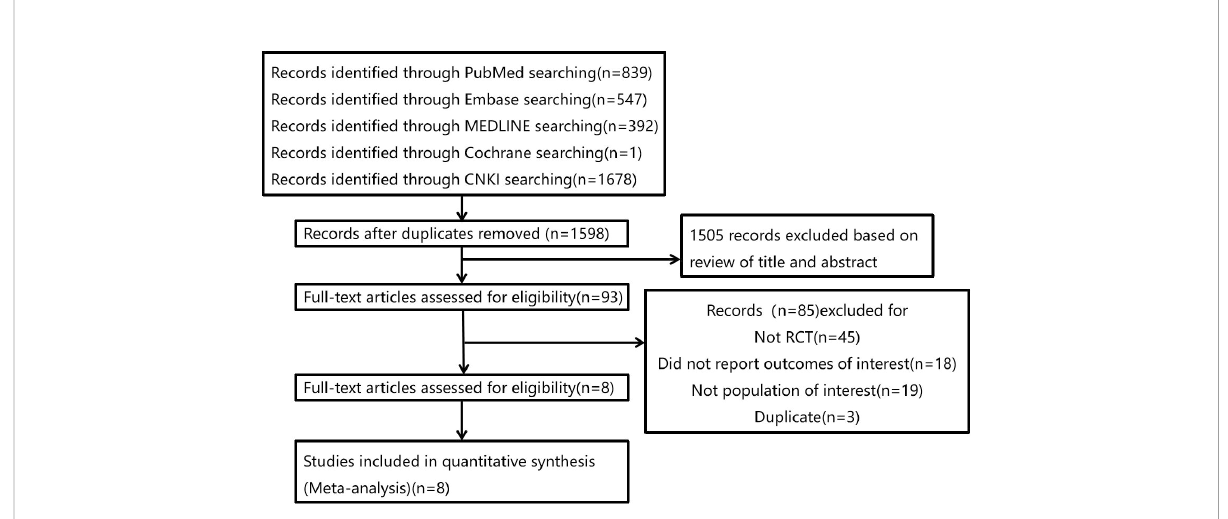
FIGURE 1 The process of study